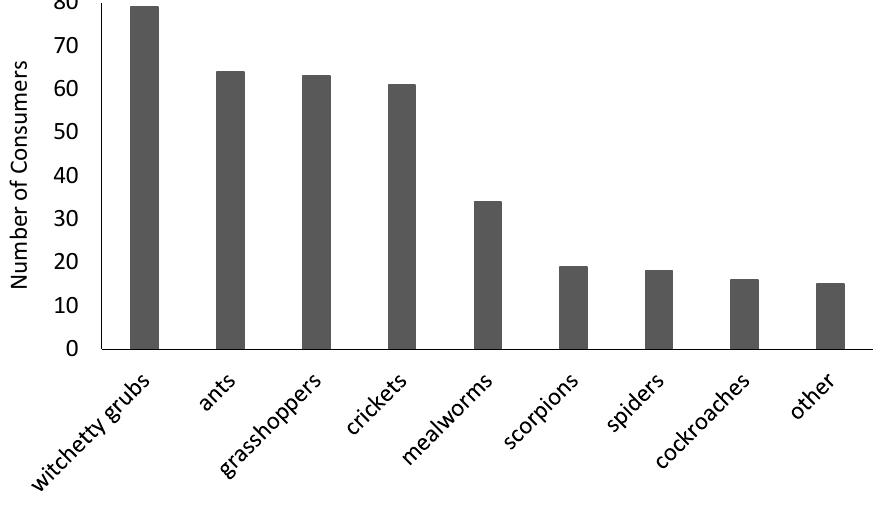
Figure 1. Histogram showing consumer ( n = 169) consumption of edible insects.